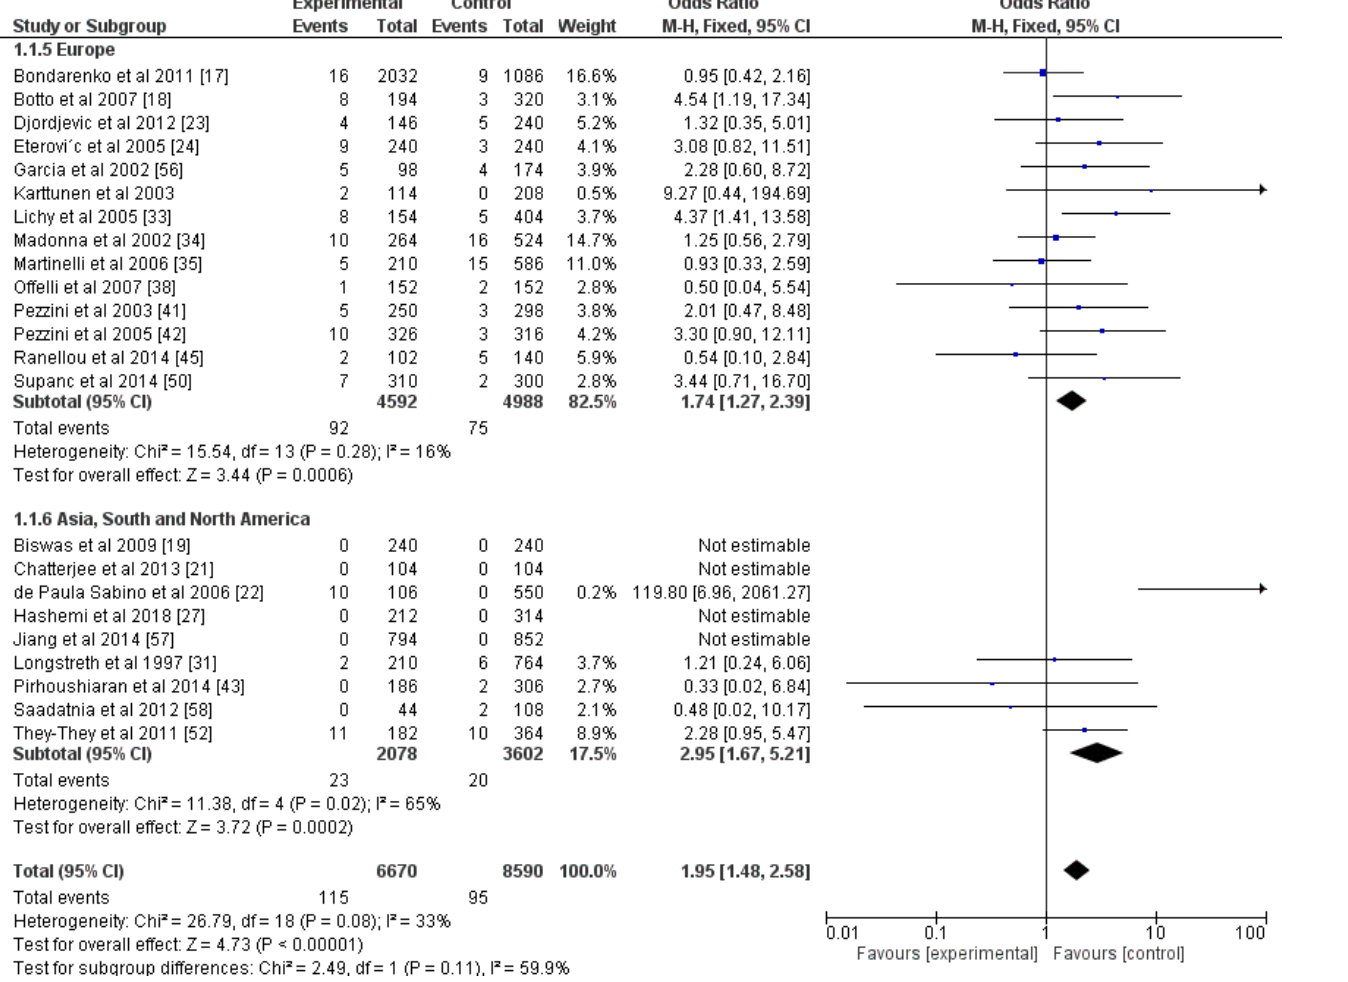
Figure 3. Forest plot for prothrombin with studies reporting prevalence of hetero- and homozygotes, and subgroup analysis for geographic localization of the studies. All included articles are presented with the corresponding numbers of mutated alleles in the experimental group and the control group, as well as the total number of alleles. Blue squares indicate odds ratios. Black rhombi indicate overall effect. Vertical line indicates null effect, and horizontal lines indicate values of the odds ratios.